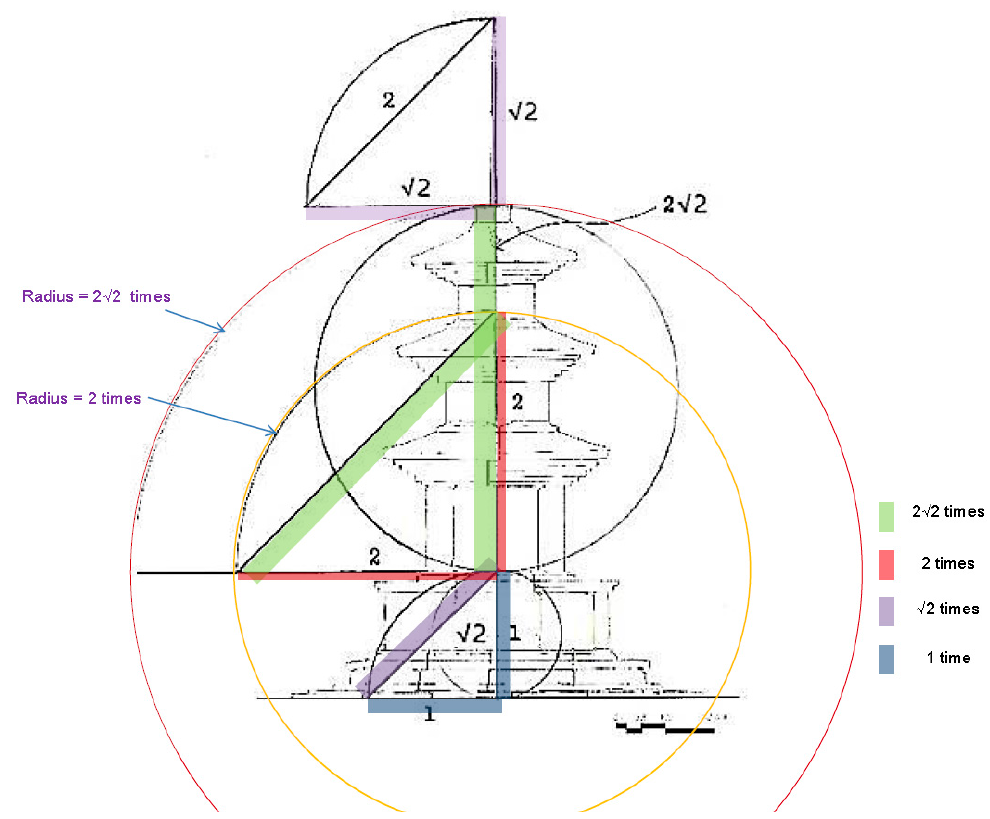
Figure 9. Proportional analysis (2) of the West Pagoda at Kam ŭ nsa Temple.